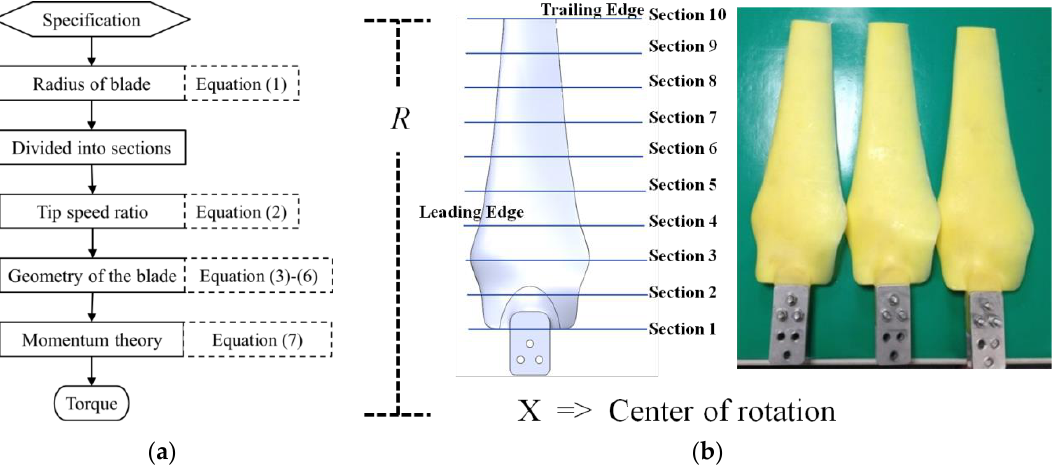
Figure 3. ( a ) Flowchart of the blade design from BEMT; and ( b ) CAD for ten sections of the blade and prototype.